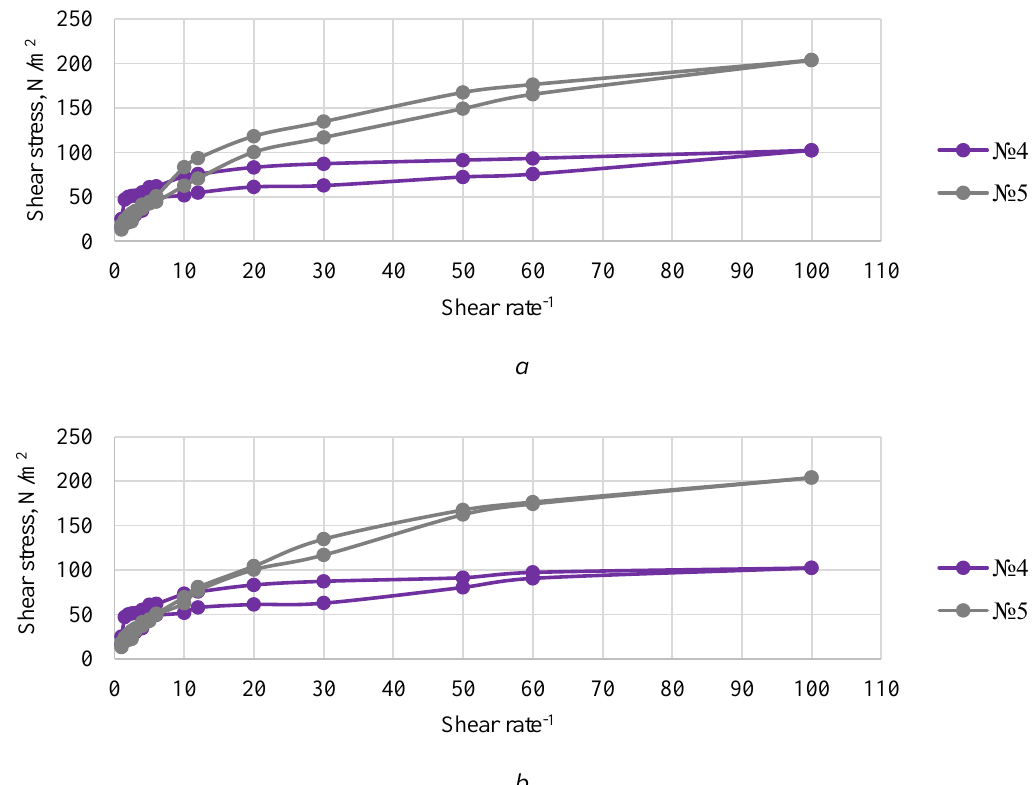
Fig. 2. Rheograms of a stream of drugs in soft dosage forms with nanoparticles of silver and gold: a – after preparation; b – after 24 months of